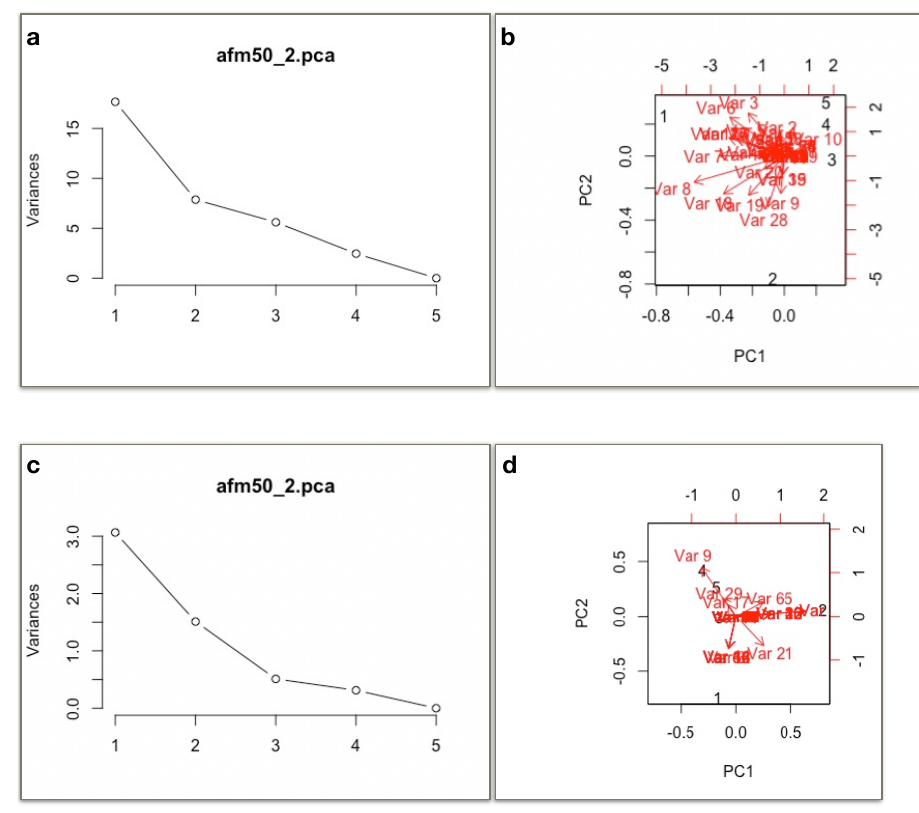
Figure 8. Visualization of principal component analysis and PCA scores of ( a ), ( b ) the crystallized PC surface and ( c ), ( d ) copied surface by